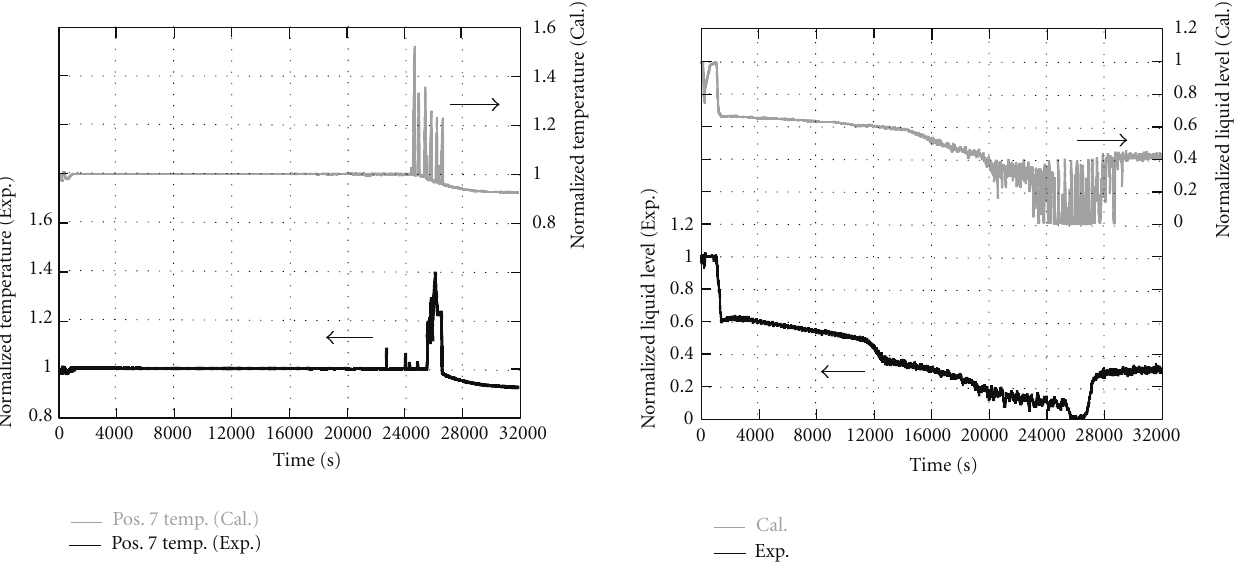
steam constantly entered probably as two-phase mixture, causing frequent temperature fluctuation. The primary fluid temperature in the downflow-side, on the other hand, stayed at the secondary-side fluid temperature and recovered to the primary saturation temperature only when the water column drains, because the SG outlet plenum was filled with subcooled coolant. Large temperature di ff erence as much as 54 K between primary and secondary coolant at around the tube entrance enhanced the e ff ective steam condensation. The SG secondary-side fluid temperature at Position 1 stayed almost at certain temperature as shown in Figure 17.